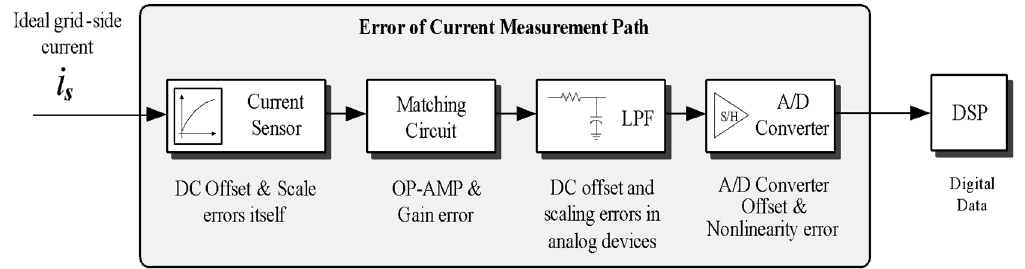
Figure 2. Current measurement process in a single-phase grid-tied system and direct current (DC) offset error occurrence in a current measuring process.